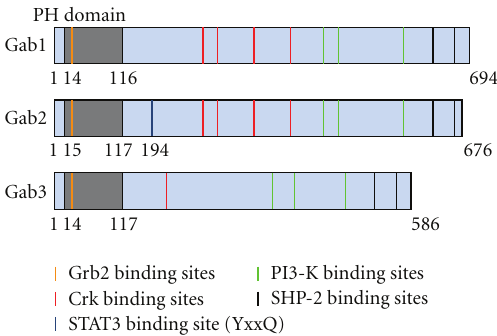
Figure 1: Gab structure and multiple binding sites. Gab molecules were originally identified as the mammalian homologs of the daughter of sevenless (DOS) drosophila adapter protein. Gab1, Gab2, and Gab3 share many common binding sites. All three Gabs have a PH domain in the amino-terminus that is believed to be essential for many functions including membrane localization. Gabs contain multiple binding sites and act as sca ff olding molecules to support cytokine signaling. Binding sites for Grb2, Crk, PI3-K, and SHP-2 have been defined and extensively